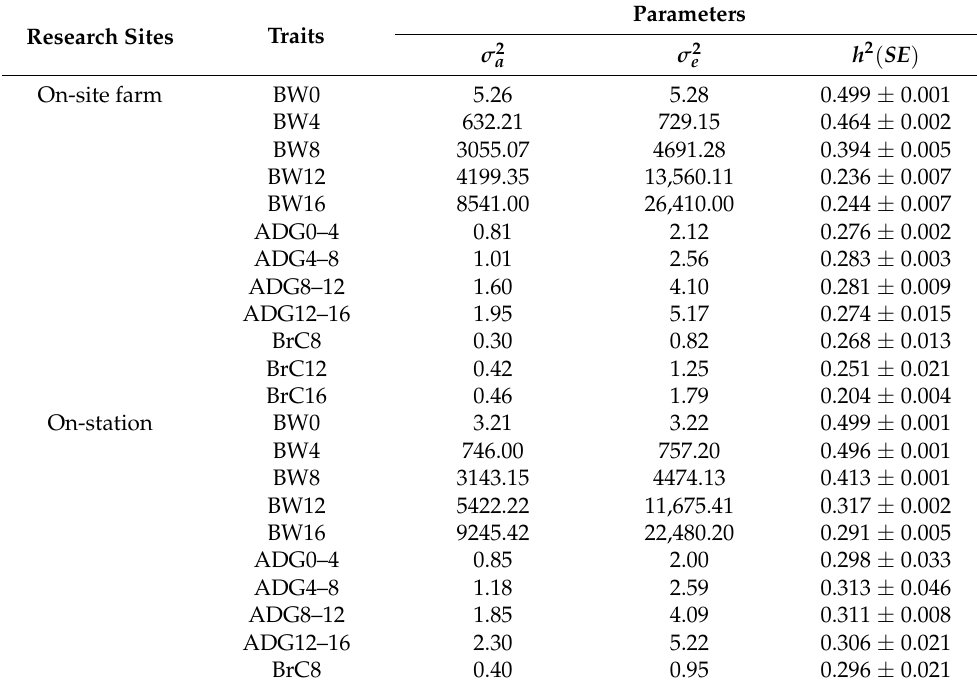
Table 1. Variance components and heritability ( ± standard error; SE) of growth traits between the on-site farm and on-station Thai native chickens (Pradu Hang